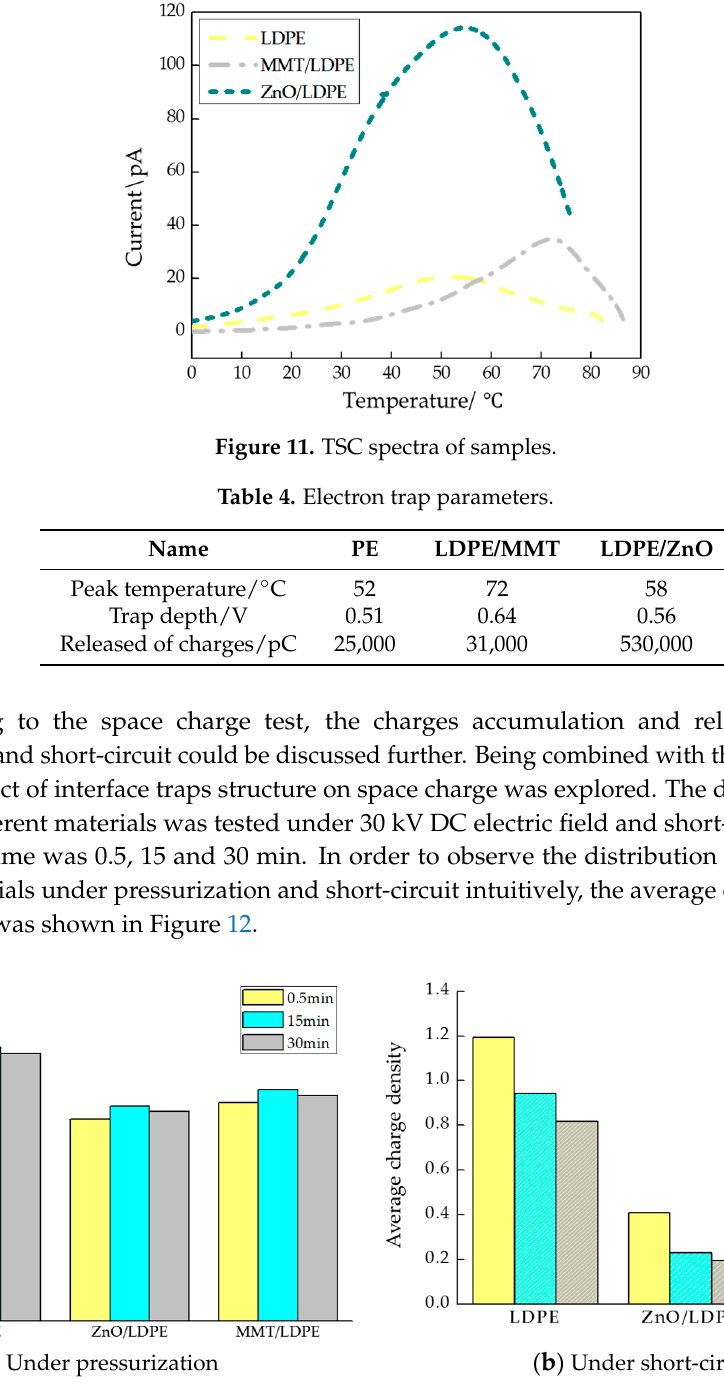
Figure 12. Distribution of space charges in different materials under pressurization and short-circuit.